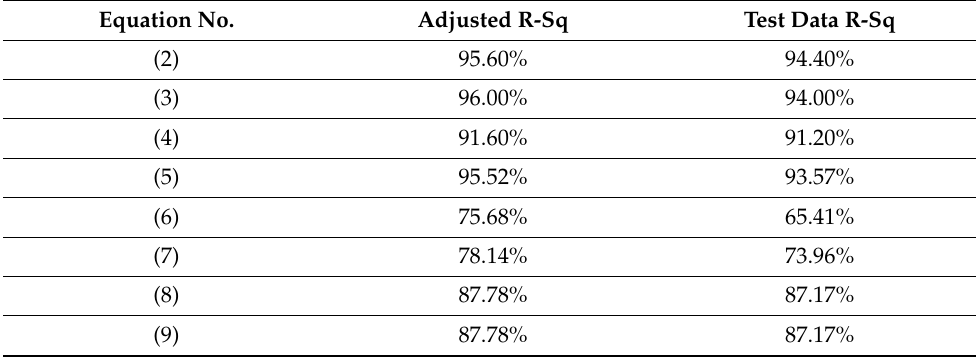
Table 7. Linear equations adjusted R-Sq and test